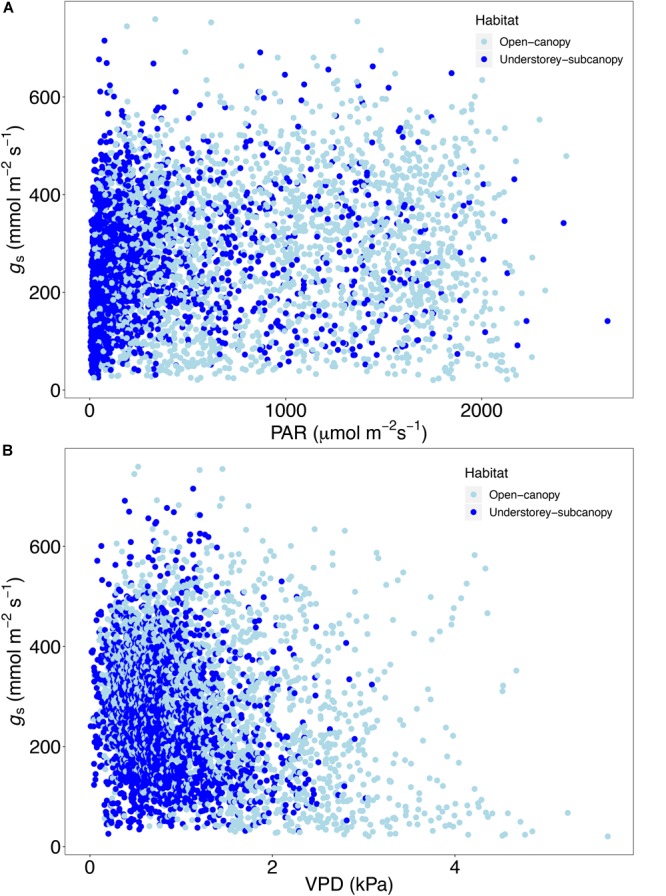
Scatter plot of stomatal conductance (gs) (n = 4273) versus (A) photosynthetically active radiation (PAR) and (B) vapor pressure deficit (VPD) in the open-canopy and understory-subcanopy habitats.